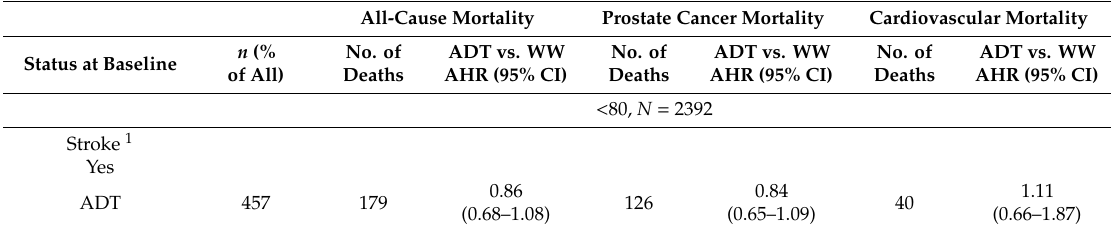
Table 3. Risk of all-cause, prostate cancer, and cardiovascular mortality associated with androgen deprivation therapy (ADT) in men with metastatic prostate cancer comparing with patients were on watchful waiting (WW) by the status of major cardiovascular diseases presenting at the baseline in age groups of < 80 and ≥ 80 years. All-Cause Mortality Prostate Cancer Mortality Cardiovascular